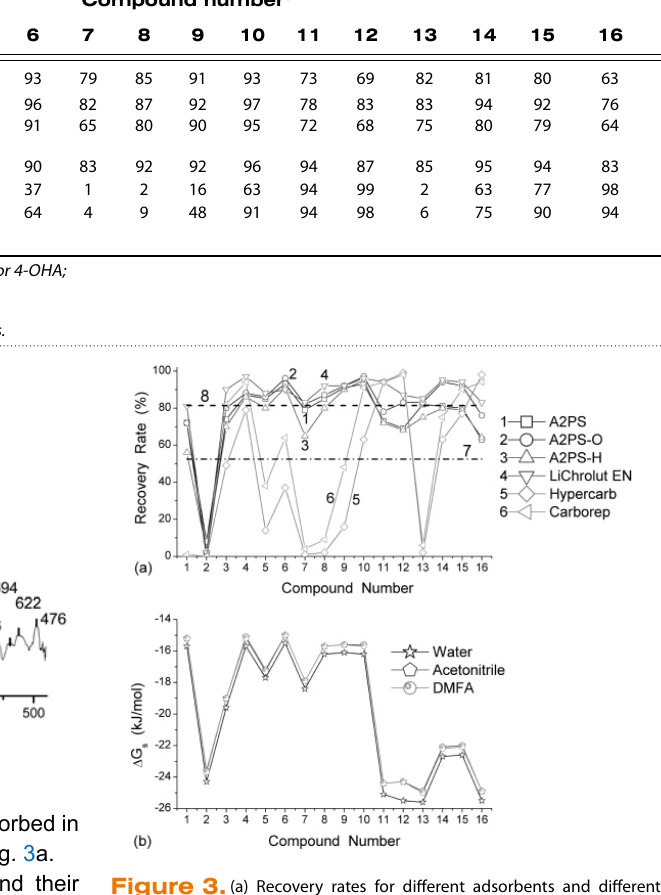
Figure 3. (a) Recovery rates for different adsorbents and different amphetamine derivatives; and average recovery for A2PS-i (line 7) and for graphitized carbons (line 8); (b) free energy of solvation of amphetamine derivatives in (1) water, (2) acetonitrile and (3) DMFA calculated using IEFPCM/B3LYP/6-31G(d,p) (compound numbers are shown in Table